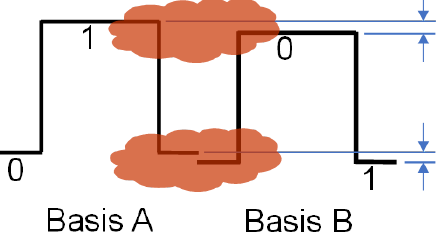
Figure 1. Comparison of differences between Basis A and Basis B.